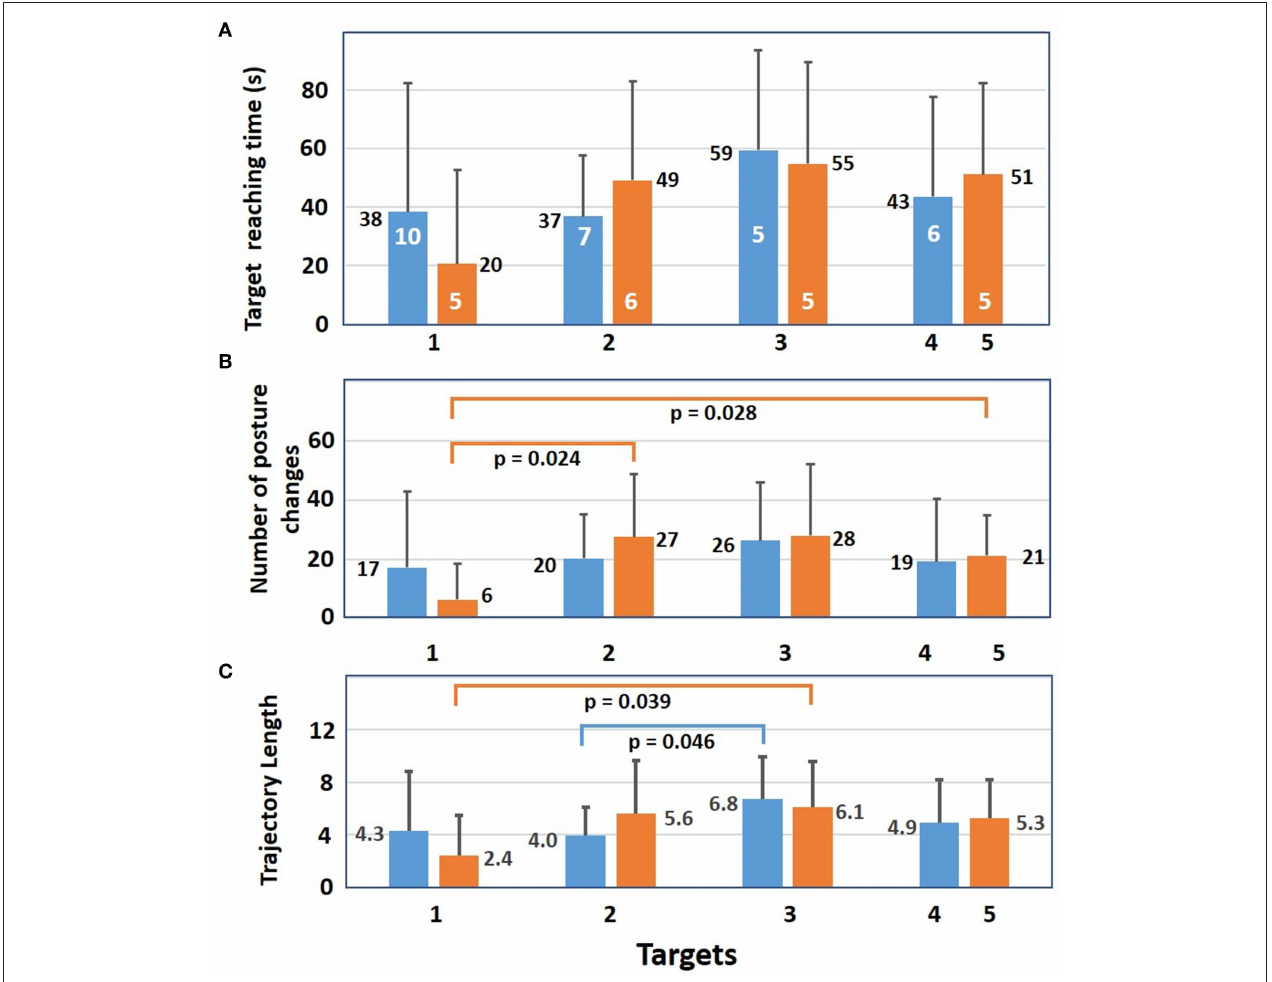
FIGURE 7 | For successful trials, mean results ( + sd) of the 12 subjects with 5 (blue bars) and with 8 static postures (orange bars). (A) Mean time needed to reach each target. Number of subjects who reached a target at least once is shown in white. (B) Mean number of posture changes needed to reach each target. For 8 static postures, there is a significant difference in the number of posture changes between targets 1 and 2 as well as between target 1 and 5. (C) Mean trajectory length needed to reach each target. Differences between targets 1 and 3 are significant for 8 static postures as well as targets 2 and 3 for five postures. Significance of independent samples t -test level is p ≤